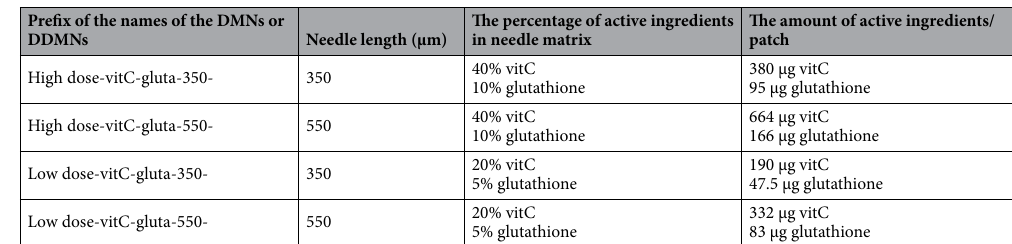
Table 1. The characteristic and active ingredients of tested microneedle.